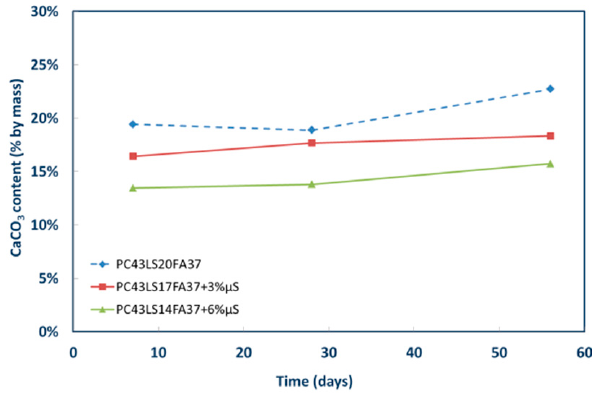
Figure 22. CaCO 3 content of μ S modified cementitious matrices based on PC43LS20FA37.